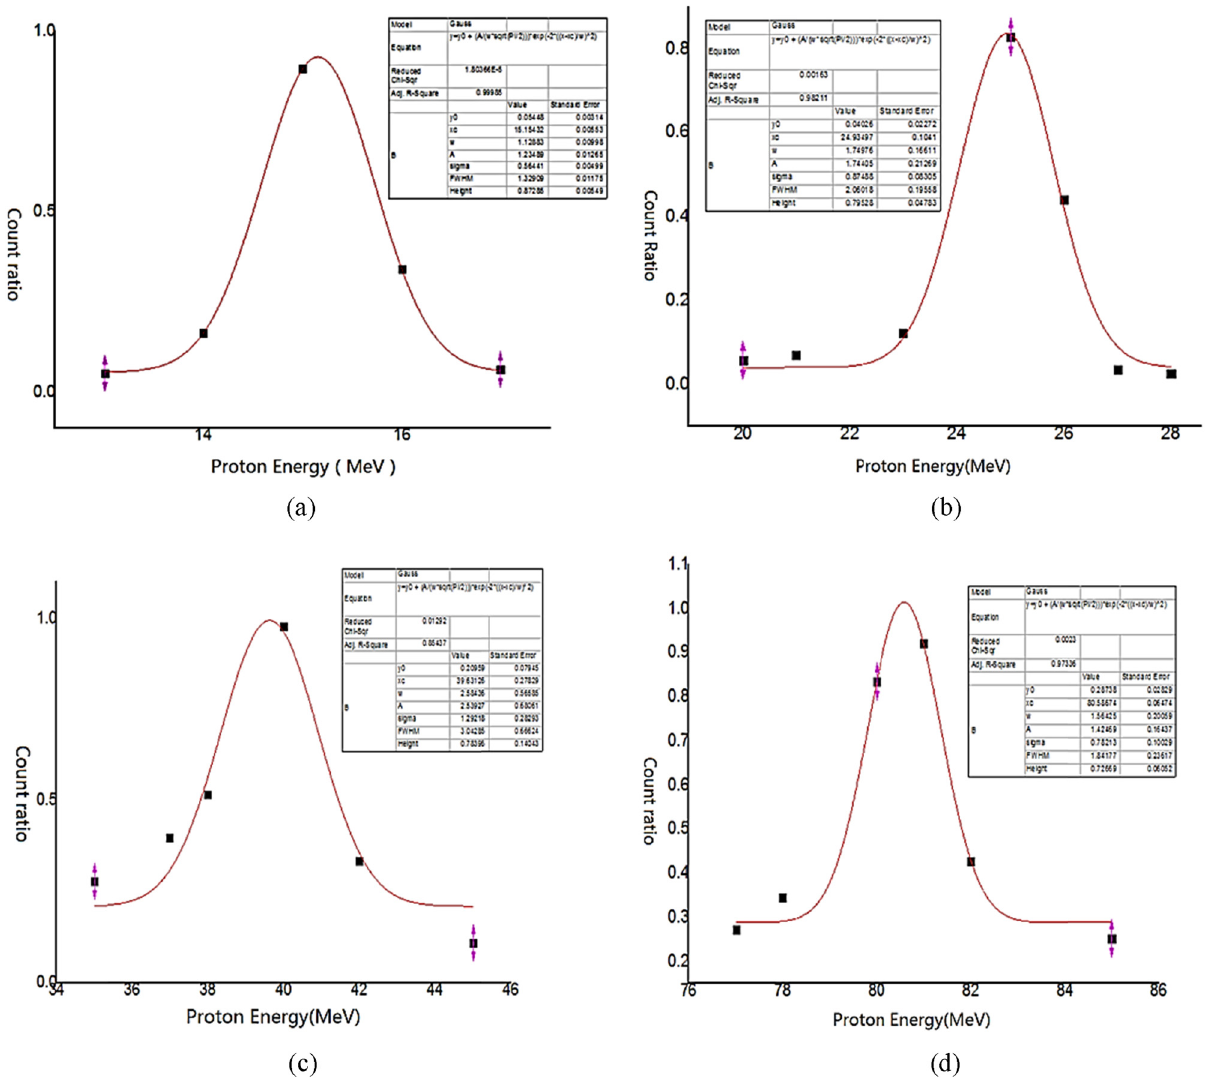
Figure 9: Energy calibration results of the proton energy spectrum at 15, 25, 40, and 80 MeV. Energy of ( a ) 15 MeV boundary fi tting, ( b ) 25 MeV boundary fi tting, ( c ) 40 MeV boundary fi tting, and ( d ) 80 MeV boundary fi tting.